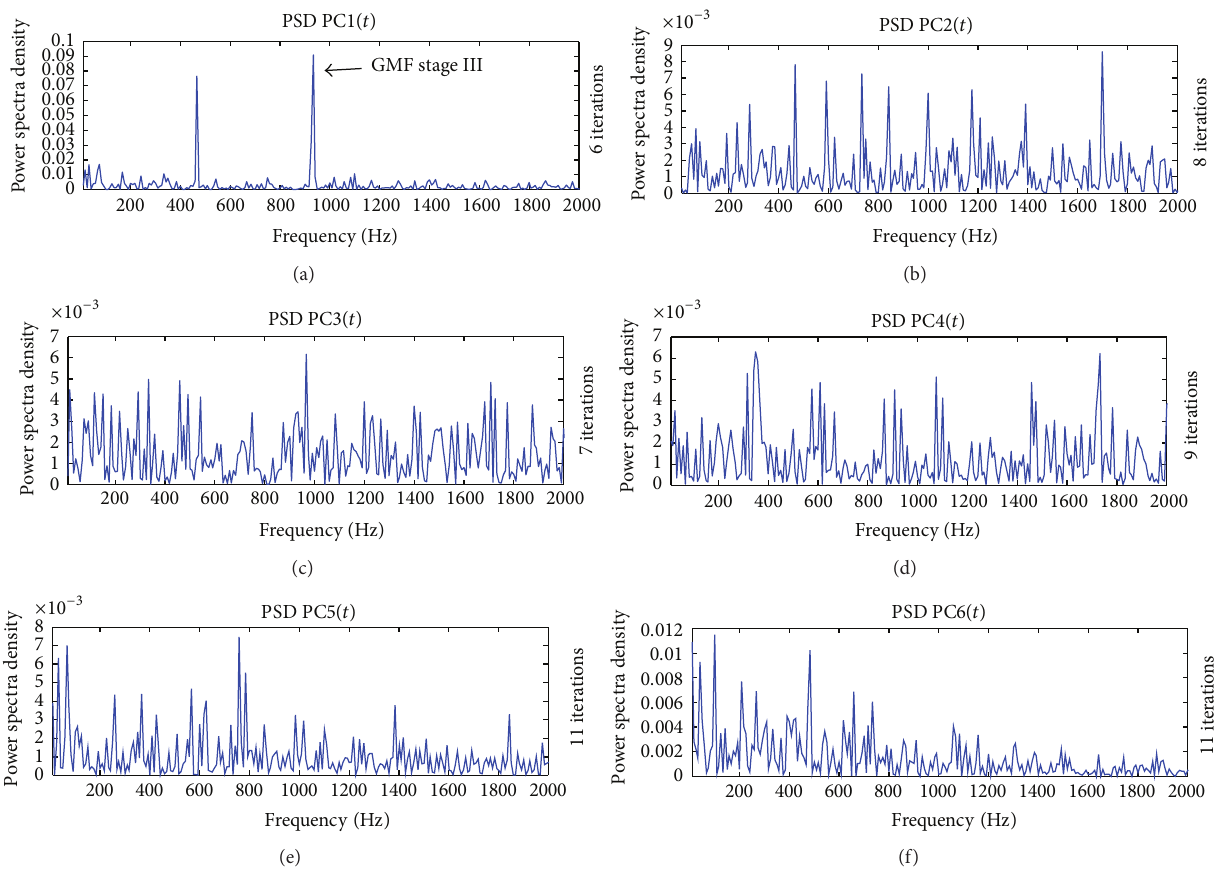
Figure 20: PSD of the envelope spectra of the obtained components from ICD (wind turbine data): (a) PC1( t ), (b) PC2 ( t ), (c) PC3( t ), (d) PC4( t ), (e) PC5( t ), and (f) PC6( t